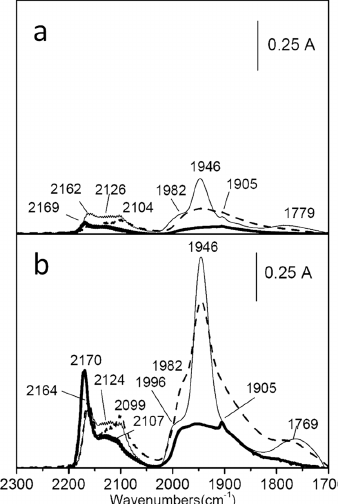
Figure 16. FTIR spectra of ZS–Pd ( a ) and ZS–PdAu ( b ) after CO adsorption at r.t on the as received samples (bold curves), on the samples pretreated at room temperature with hydrogen (fine curves) and pretreated with hydrogen and oxygen (dashed curves). The spectra have been normalized to the same Pd content. Reprinted from J. Catal., 257, F. Menegazzo, P. Burti, M. Signoretto, M. Manzoli, S.